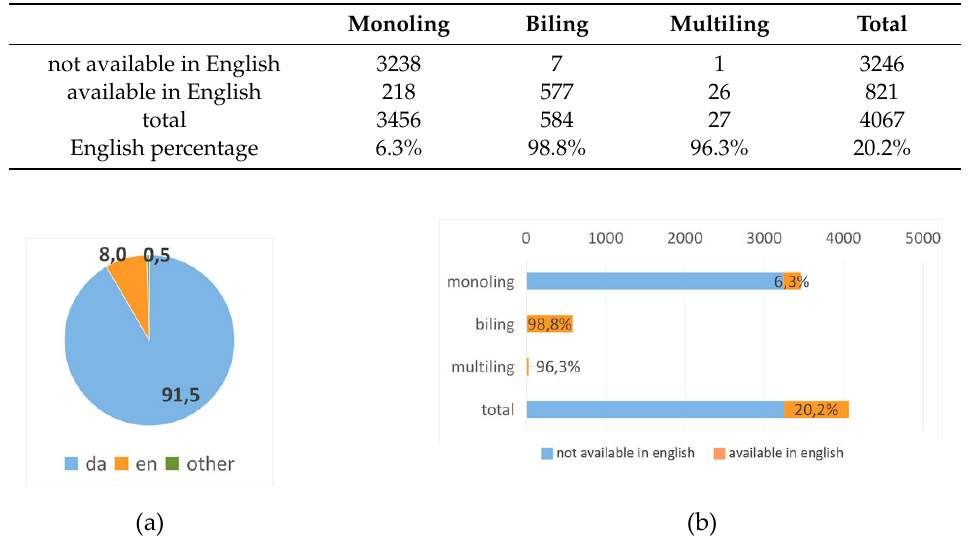
Figure A7. Visualization of the results for domain dk. ( a ) Primary languages pie chart and ( b ) English